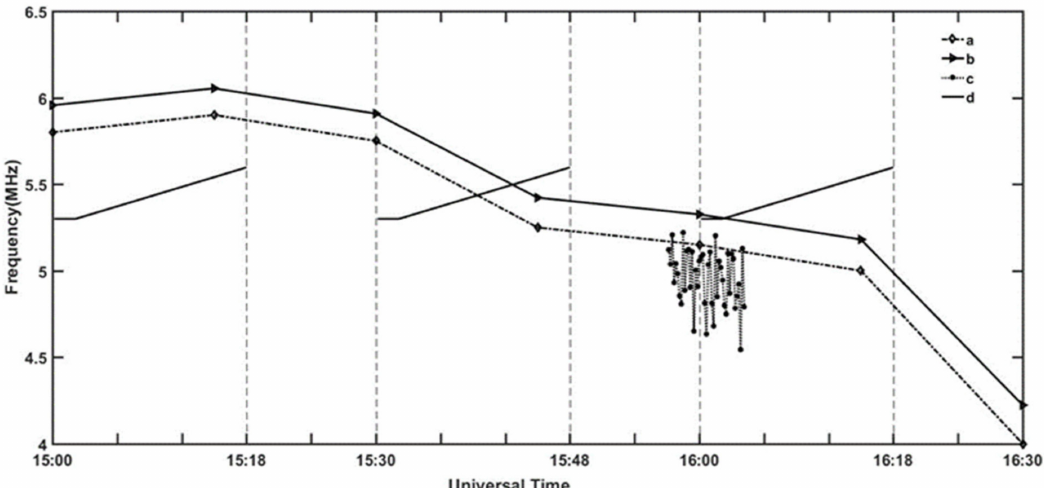
Figure 1. Cut-off frequency ( f 0 F 2 ) measured by the altitude sounding station in Tromsø (curve a) and incoherent scattering radar (curve c), the upper hybrid frequency (curve b) calculated by curve a, and the pump frequency (curve d) corresponding to experiments on 22 February 2012,